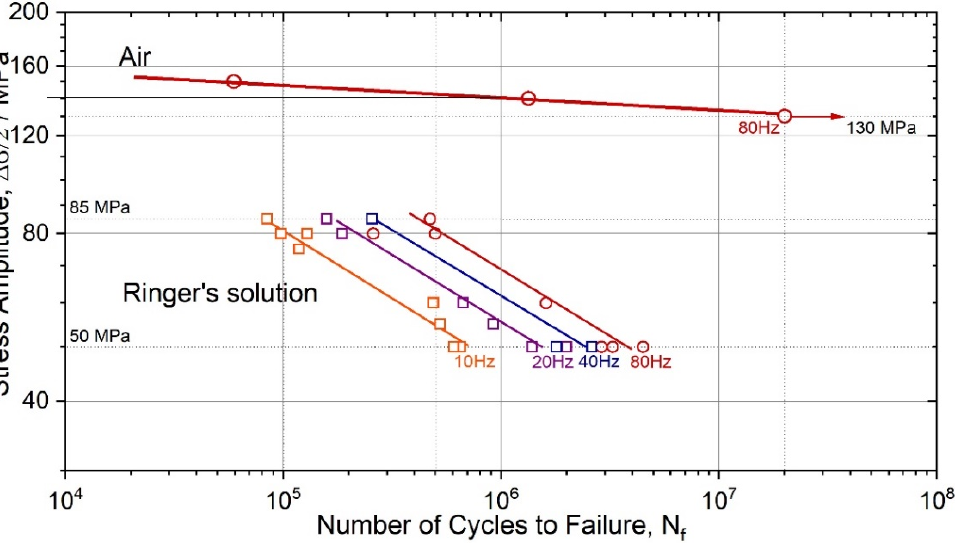
Figure 2. Wöhler plot for the ZK60 specimens with the ground surface tested at different frequencies—10, 20, 40 and 80 Hz in air and Ringer’s solution.